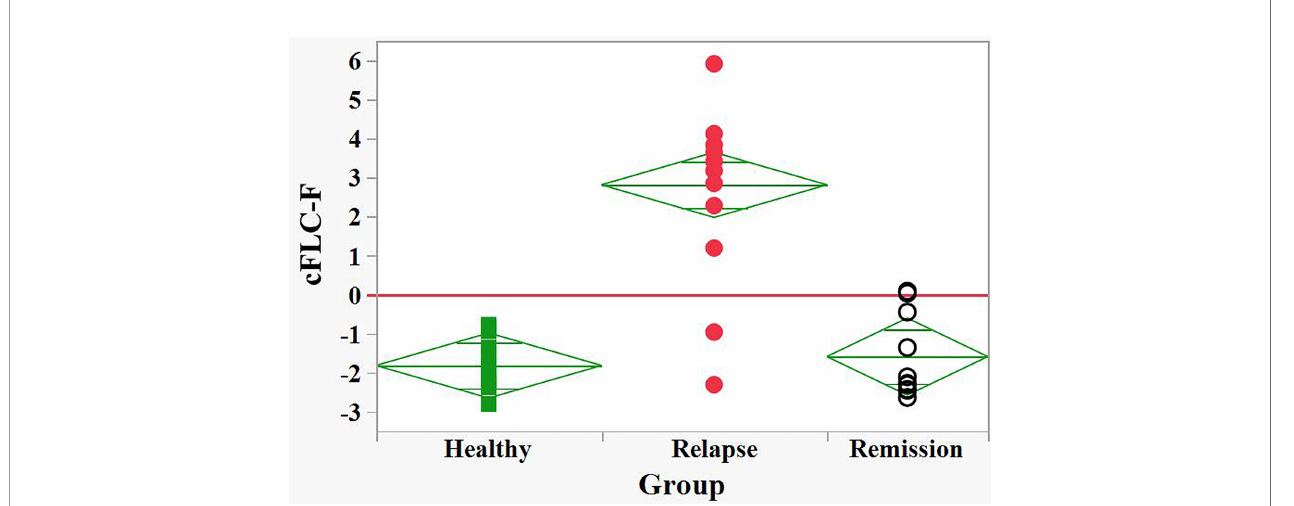
FIGURE 3 | Discrimination between relapse and remision groups of naive POMS patients and healthy children by the FLC based Firth ’ s logistic regression function, cFLC-F. cFLC-F values were calculated for each individual ( Supplement 1 ). “ Relapse ” - red fi lled circles, “ Remission ” - black empty circles, and “ Healthy ” groups - green fi lled squares.) Effective discrimination between healthy children and POMS patients in relapse, as well as between relapse and remission groups was observed (cut-off value, cFLC-F =